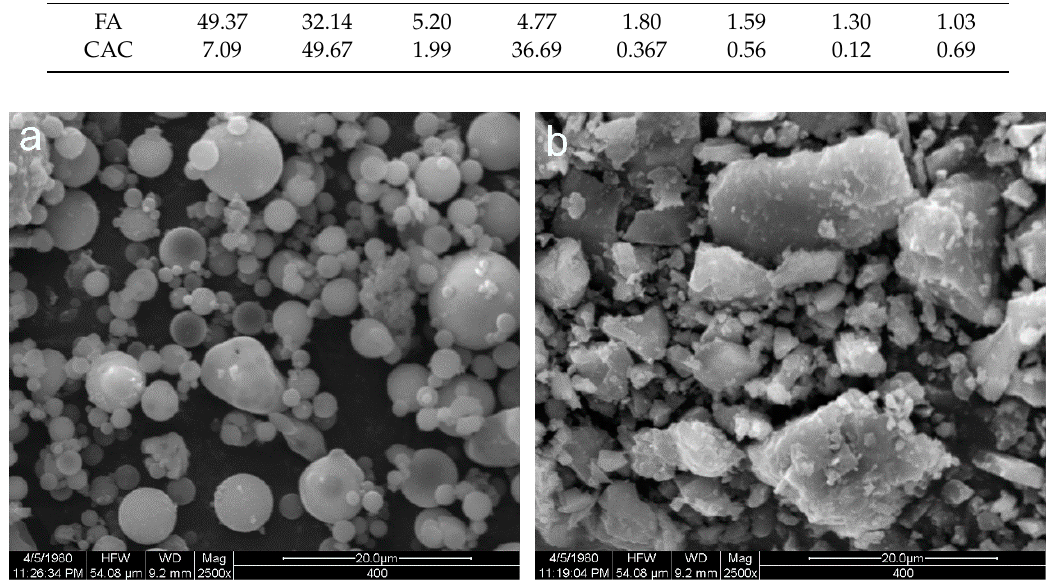
Figure 1. SEM images of ( a ) fly ash and ( b ) calcium aluminate cement (CAC) particles. Table 1. Chemical composition of materials.